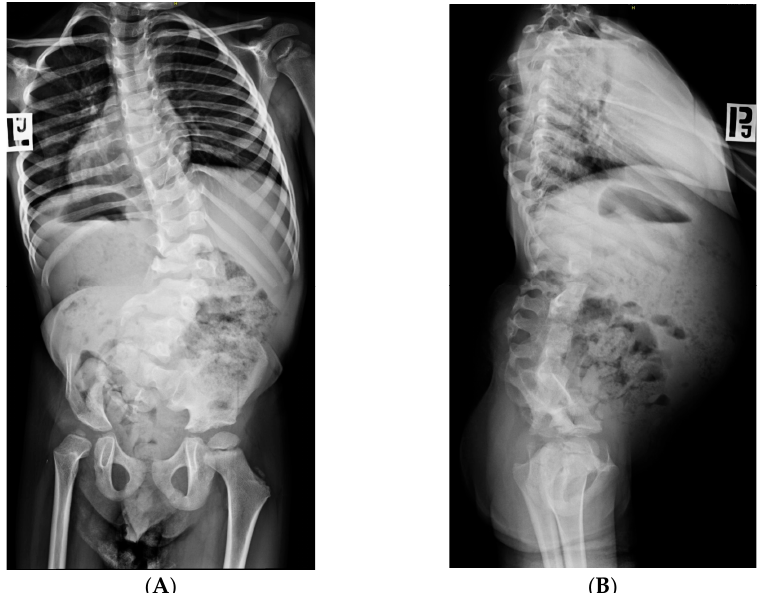
Figure 4. A boy with partial absence of sacrum, scoliosis and hip dysplasia. ( A )—ap view, ( B )— lateral view. ( B )—lateral